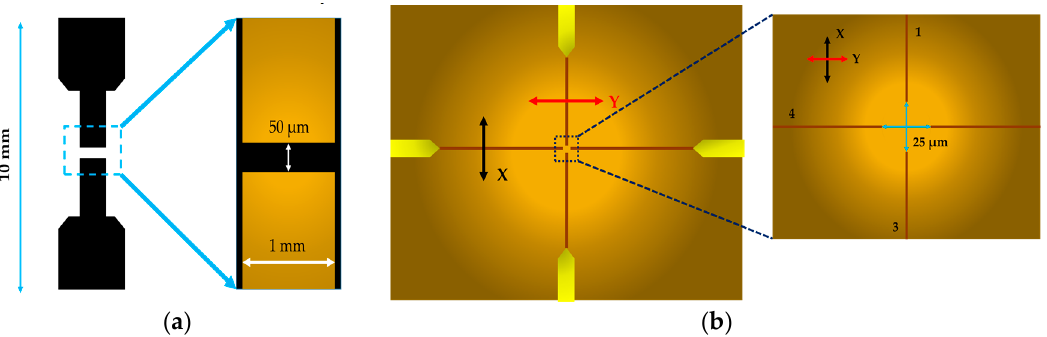
Figure 14. ( a ) In-plane gold electrodes having a 1-mm width and separated by 50 µ m in a glass wafer; ( b ) two pairs of electrodes in a cross configuration to inspect the conductivity in mutually perpendicular directions. The inset shows the gap in between the electrodes.